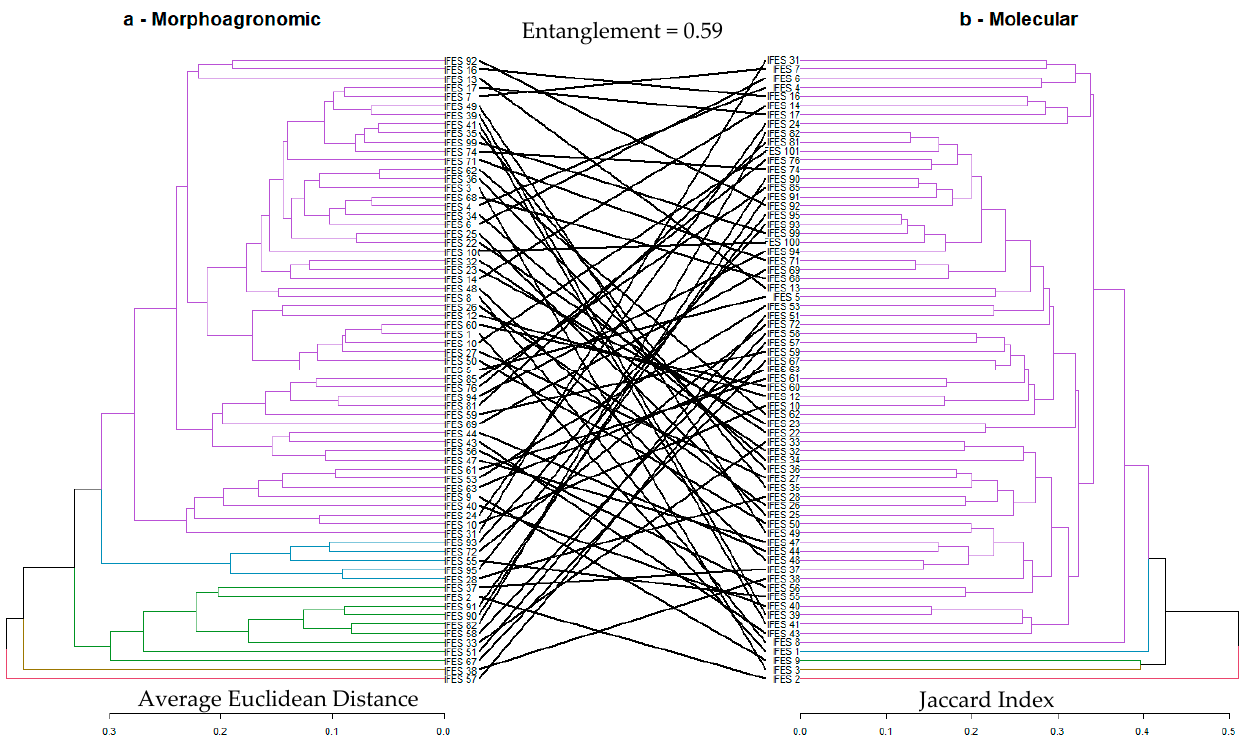
Figure 3. UPGMA dendrograms based on ( a ) morpho-agronomic traits and ( b ) genetic diversity of 69 pepper